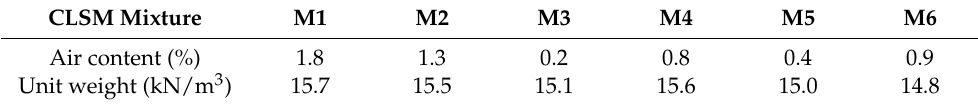
Table 3. Air contents and unit weights of the CLSM mixtures with six different fly